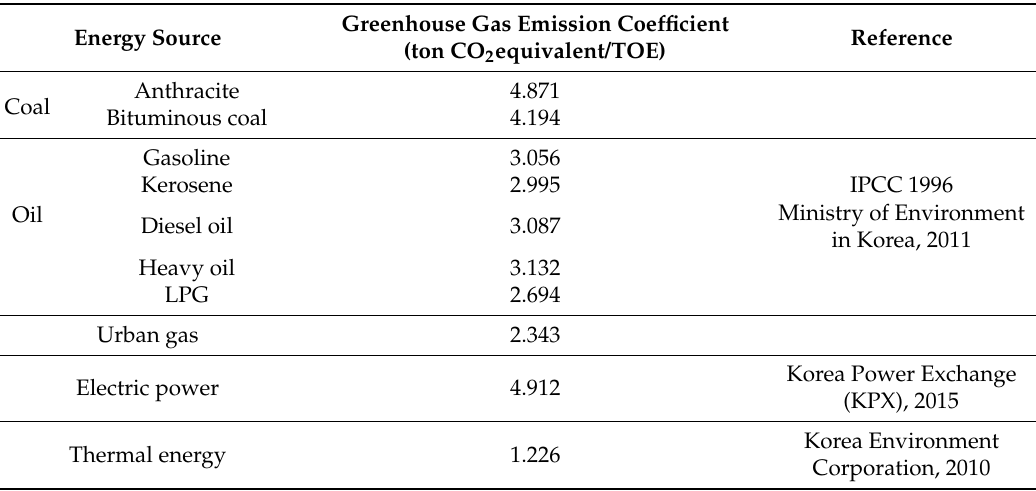
Table 4. Database of by energy source greenhouse gas emission coefficient.